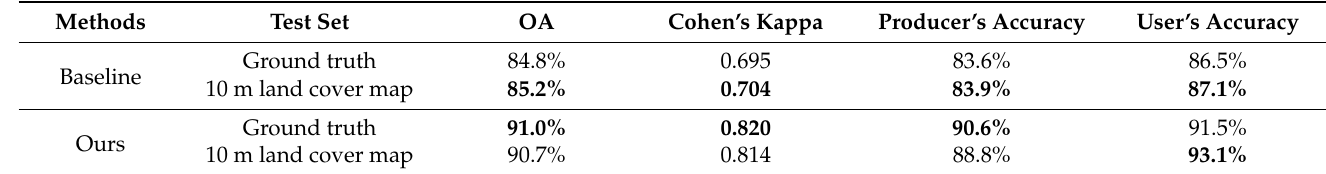
Table 10. Test results of ground truth data and 10 m land cover